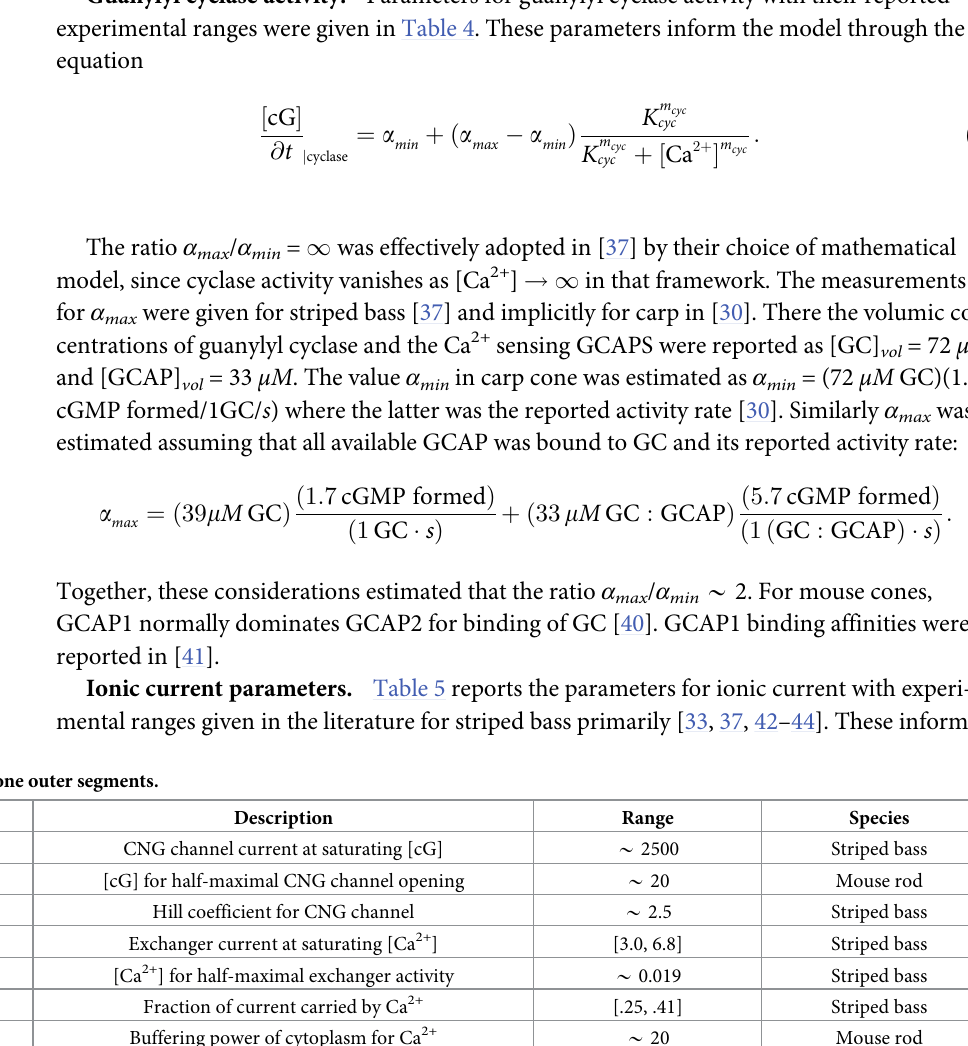
value was reported as unity [38, 39].